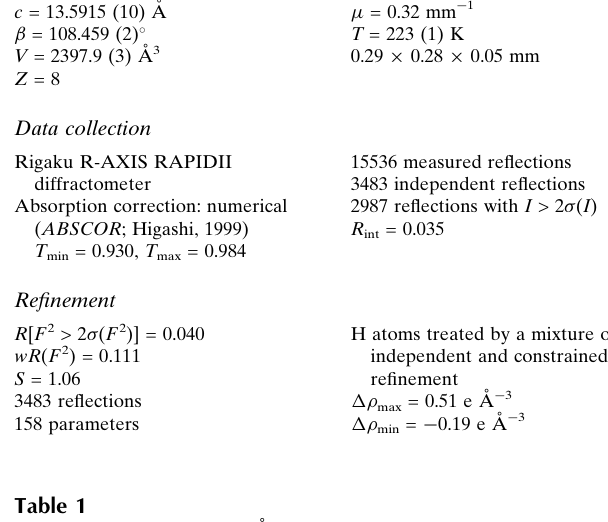
Hydrogen-bond geometry (A˚ , (cid:3) ).